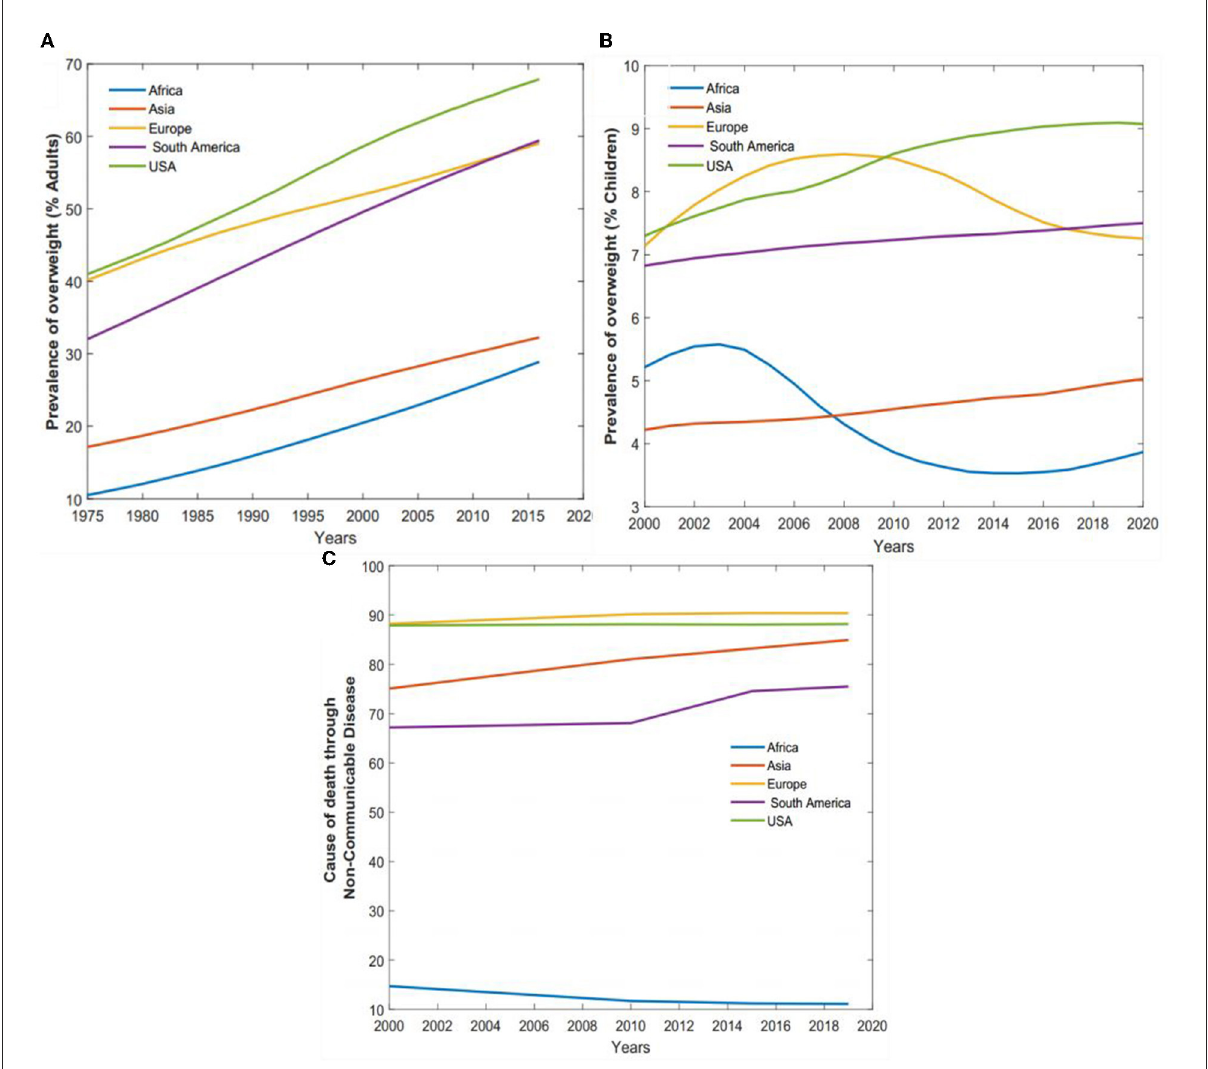
FIGURE5 The prevalence of health-related implications of a consistent intake of unhealthy food over time. (A) Percentage prevalence of overweight in adults from 1975 to 2016. (B) Percentage prevalence of overweight in children under 5 years from 2000 to 2020. (C) Percentage total cost of death due to non-communicable diseases from 2000 to